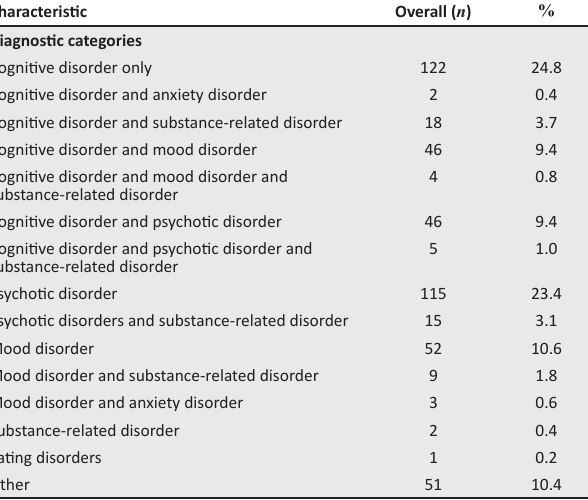
TABLE 2: Diagnostic categories and comorbid psychiatric conditions of patients ( n = 491) † Characteristic